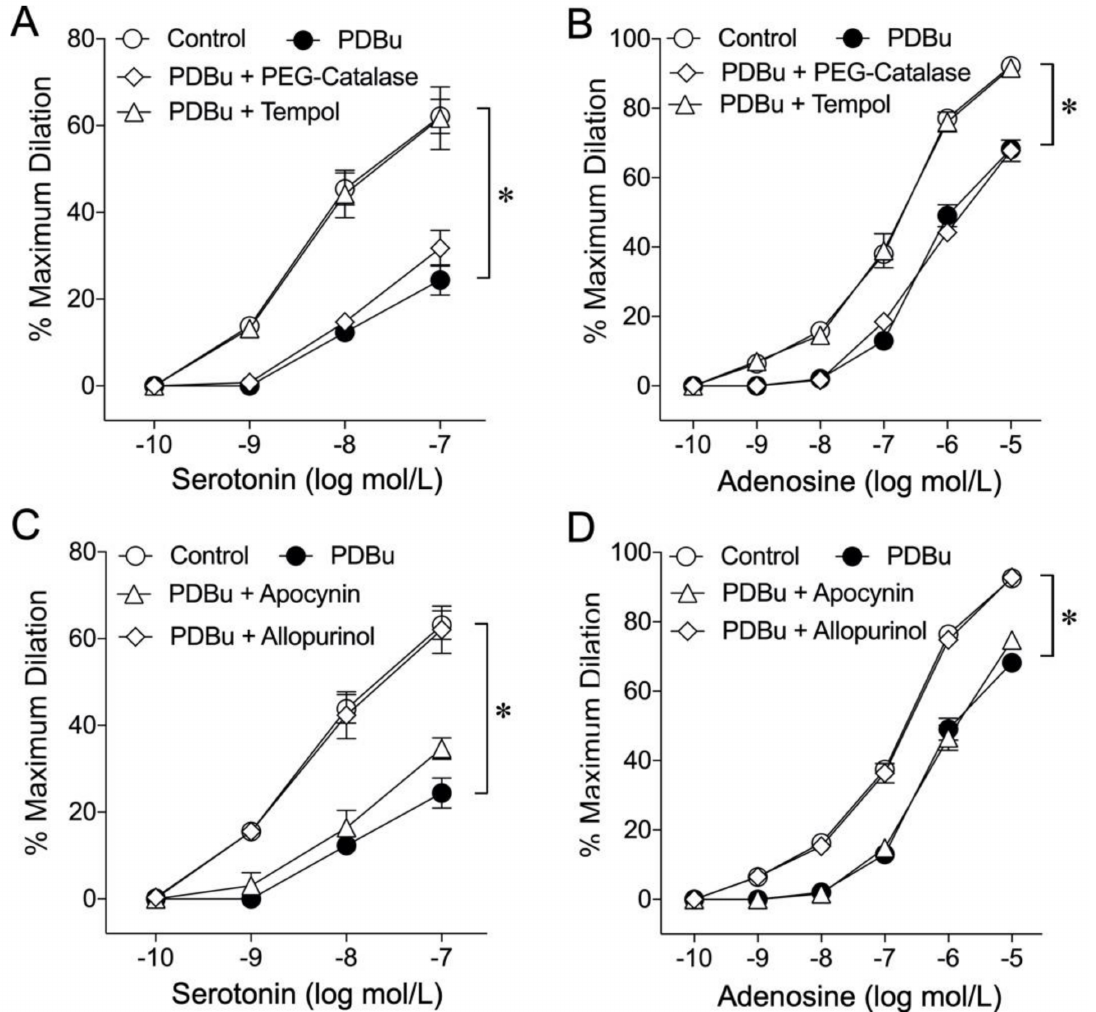
Figure 3. Role of oxidative stress in the adverse effect of PKC activation. The inhibitory effect of PDBu on vasodilations in response to serotonin ( A ) and adenosine ( B ) was prevented by pre-treating the vessels with the superoxide scavenger Tempol (1 mmol/L, n = 5) but not by the cell permeable H 2 O 2 scavenger PEG-catalase (500 U/mL, n = 5). The inhibitory effect of PDBu on vasodilations induced by serotonin ( C ) and adenosine ( D ) was prevented in vessels treated with the xanthine oxidase inhibitor allopurinol (100 µ mol/L, n = 5). However, the NAD(P)H oxidase inhibitor apocynin (100 µ mol/L, n = 5) had no effect on PDBu-induced vascular impairment in response to serotonin ( C ) and adenosine ( D ). * p < 0.05 vs. the control, two-way repeated measures ANOVA with Tukey’s multiple comparison